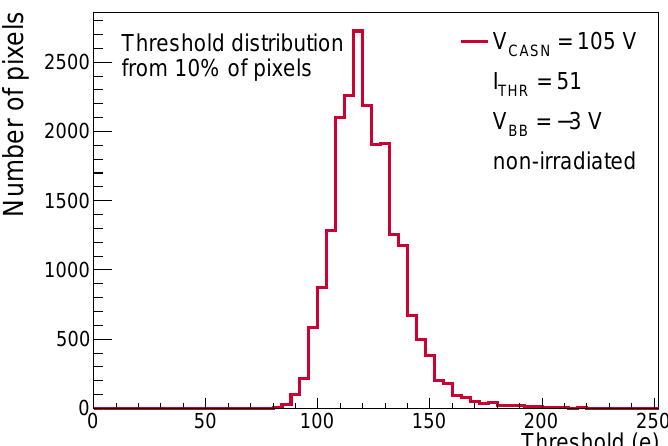
Figure 7. Distribution of charge thresholds from 10% of pixels of a non-irradiated